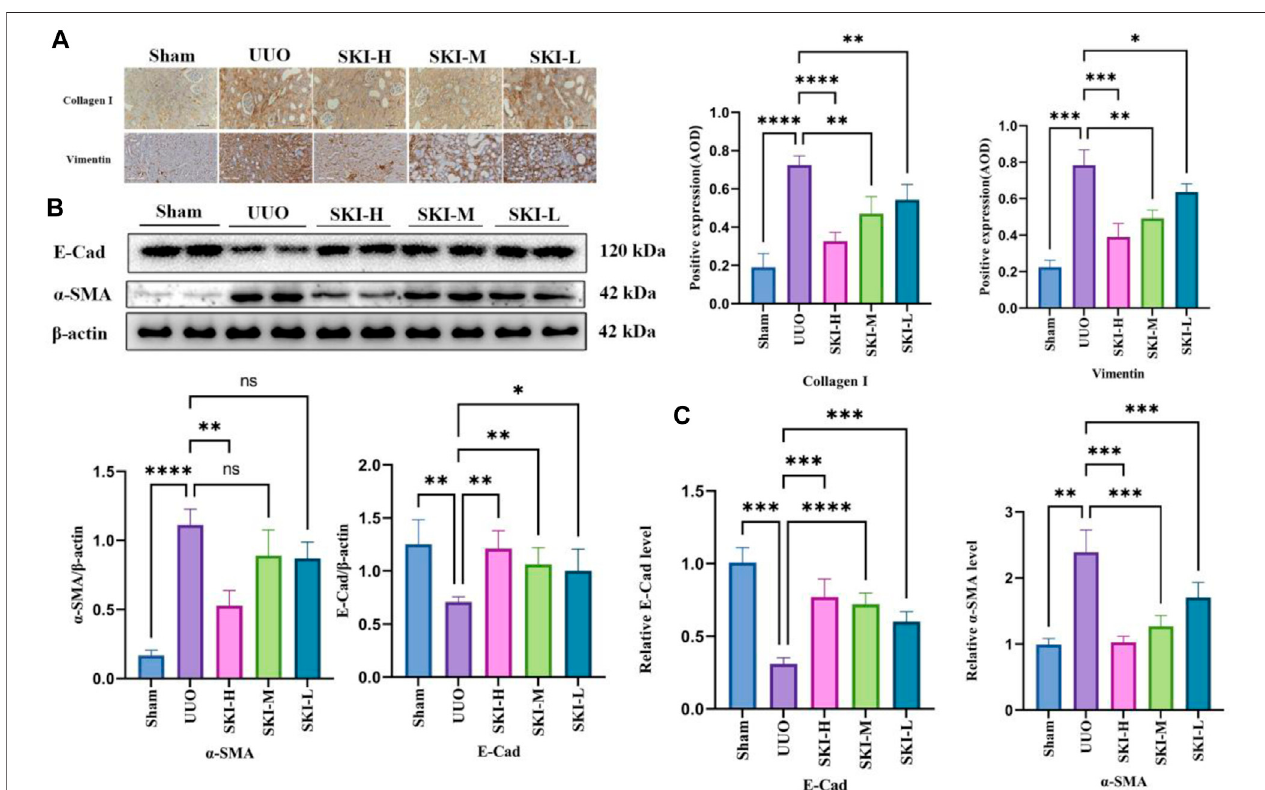
FIGURE4| EffectsofShenkanginjectiononECMdepositionandEMTformationinthekidneyofUUOmice. (A) TheexpressionofCOL-Iandvimentinproteininthe kidney tissue sections by immunohistochemistry, scale bar, 100 μ m. (B) The expression of α -SMA and E-Cad in renal tissue lysates by Western blot and quanti fi ed by densitometry. (C) The expression of α -SMA and E-Cad mRNA in kidney tissue by RT-PCR.